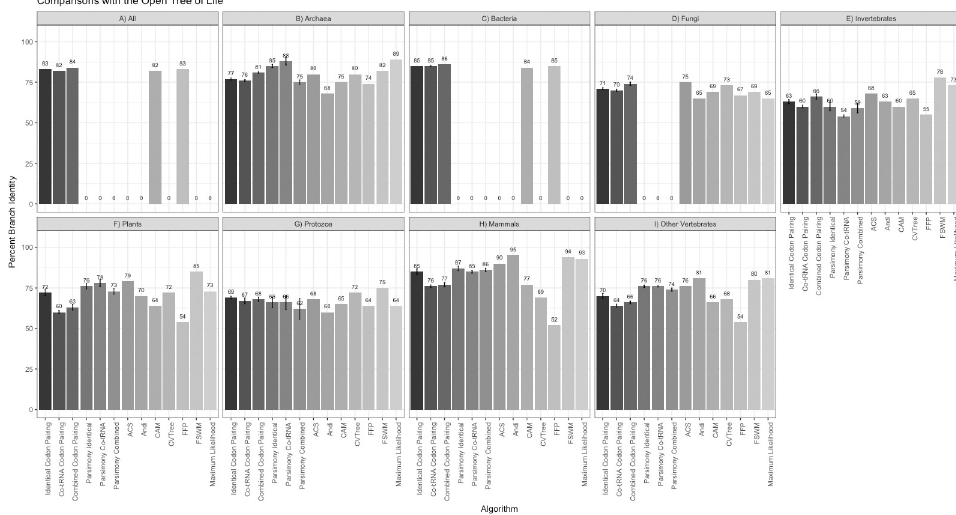
Fig 1. Percent edge overlap for comparisons of each algorithm against the OTL. The alignment-free and parsimony codon pairing methods report the mean percent edge overlap with the OTL based on using different ribosome windows from 2–11. Error bars are reported for the codon pairing methods, signifying one standard deviation from the mean. The other methods were previously reported in Miller, McKinnon [12] and are used for comparison.